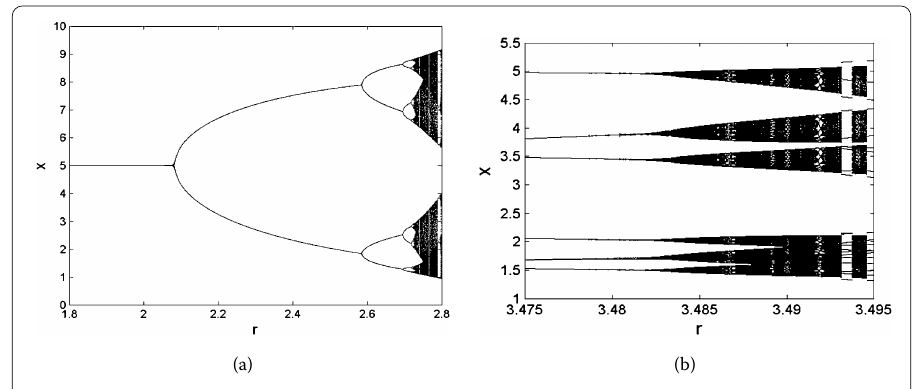
Figure 1 Numerical simulations of equation (1.2). (a) Flip bifurcation of model (1.2) for k = 5, c = 0.2, m = 0.00001, b = 100, a = 0.001; (b) NS bifurcation of model (1.2) for k = 5, c = 0.2, m = 0.00001, b = 100, a = 0.008. Initial value ( x 0 , y 0 ) =